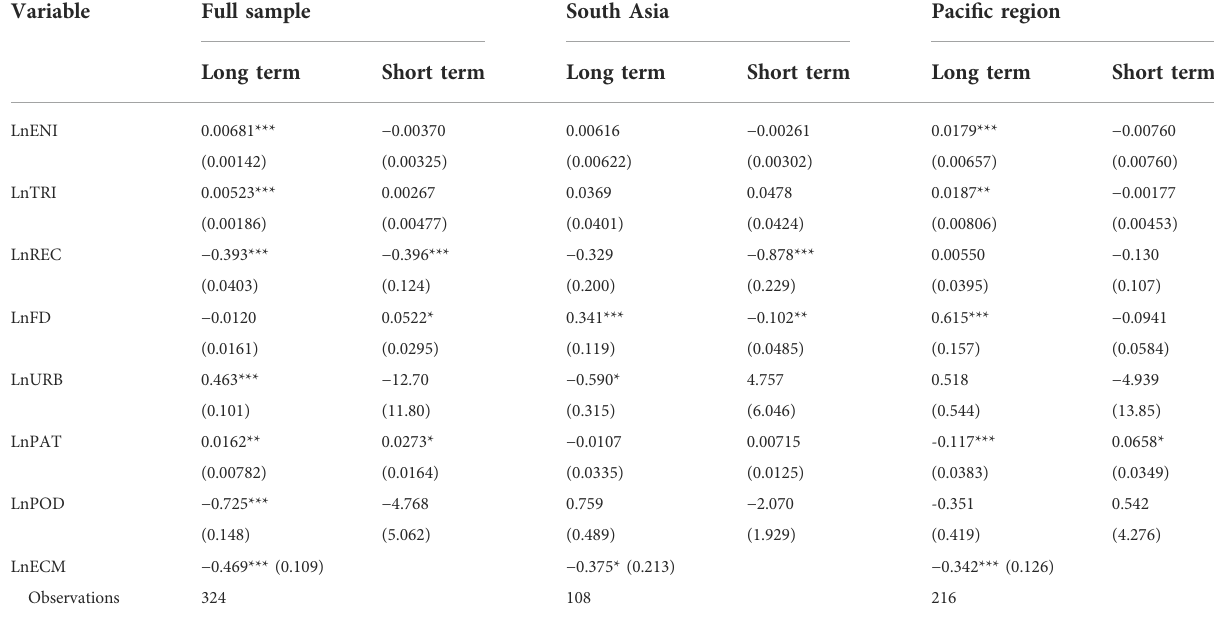
TABLE 5 Empirical results of the ARDL model.